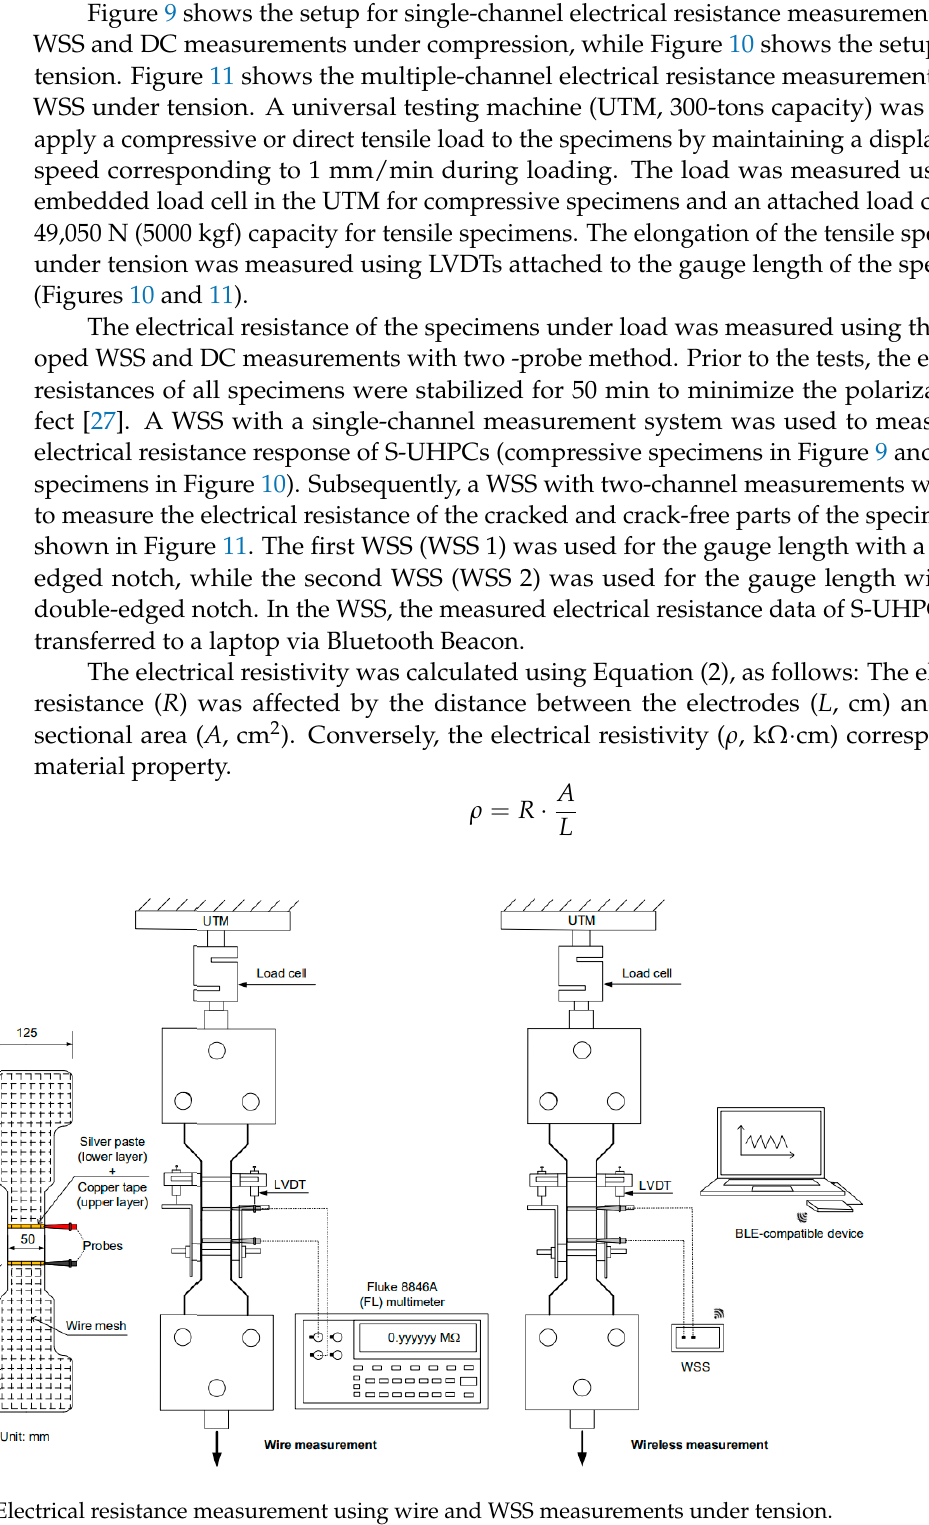
Figure 11. Test setup for multiple electrical resistance measurements using WSS under tension.